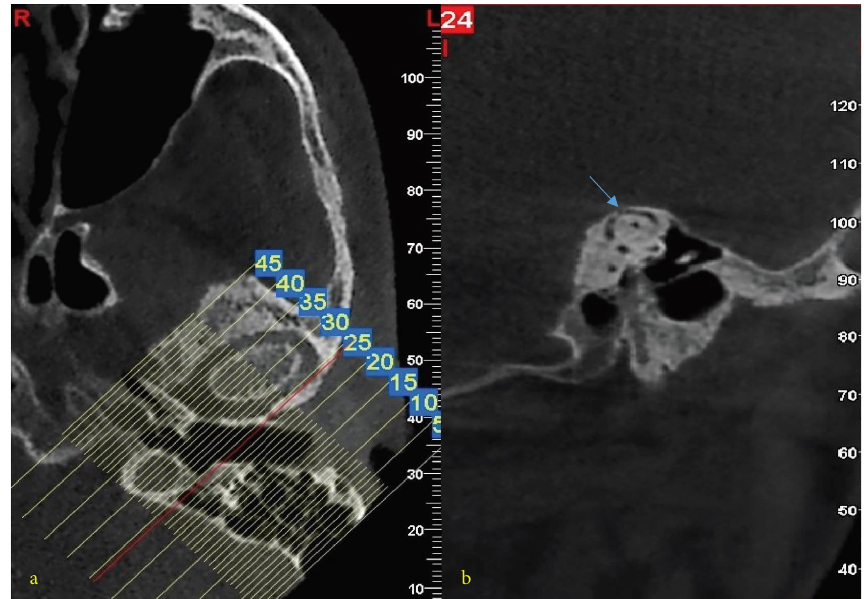
Figure 2: P¨oschl € transverse sectioning to depict superior semicircular canal (SSC) (a) and visualize SSC with a dehiscent roof (blue arrow) (b).